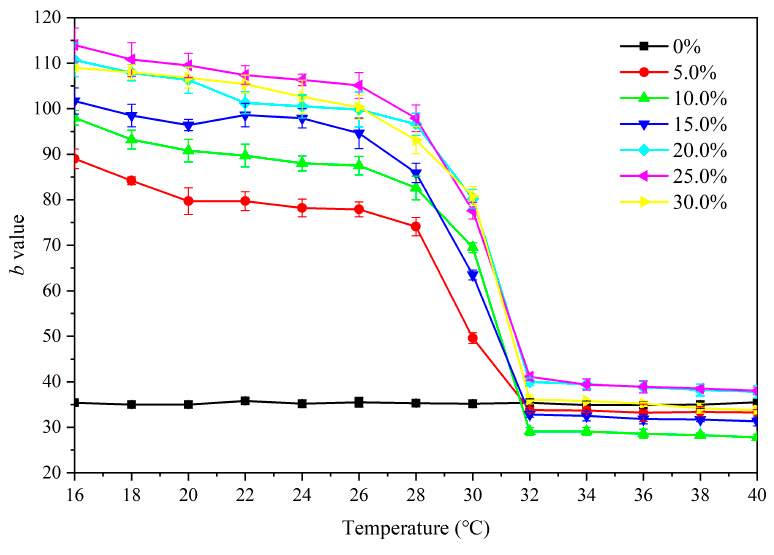
Figure 9. E ff ect of temperature increase (16–40 ◦ C) on the b value of primer film added with Figure 9. Effect of temperature increase (16–40 °C) on the b value of primer film added with thermochromic thermochromic microcapsules.